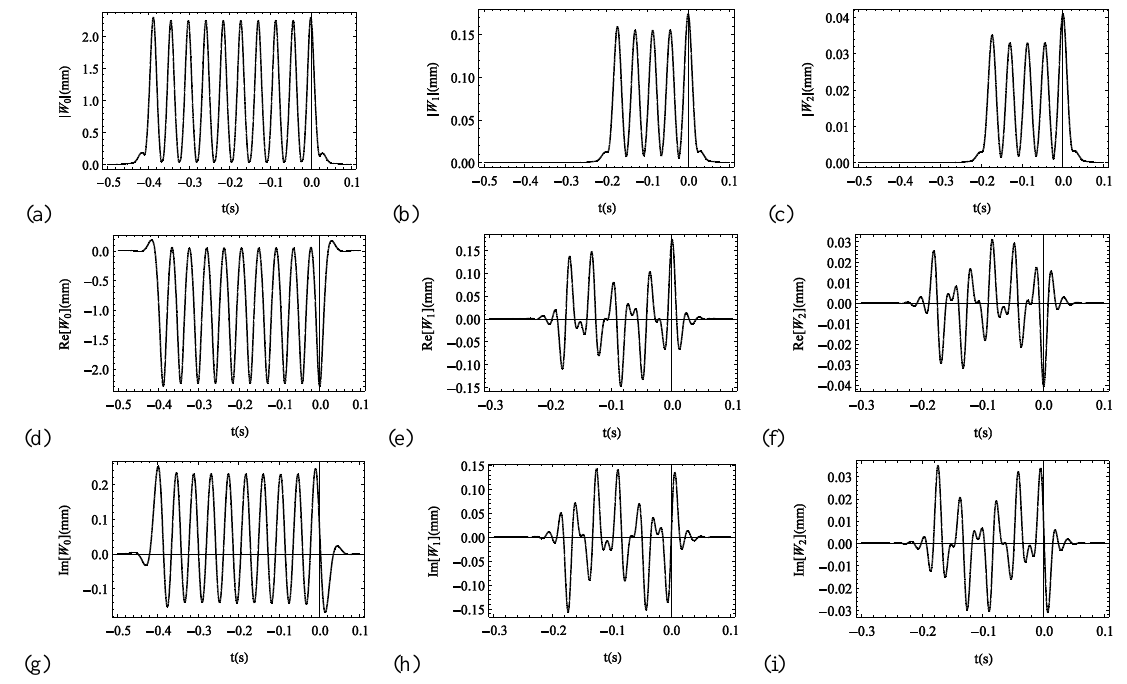
Fig. 4. Terms of Adomian’s decomposition for the vertical